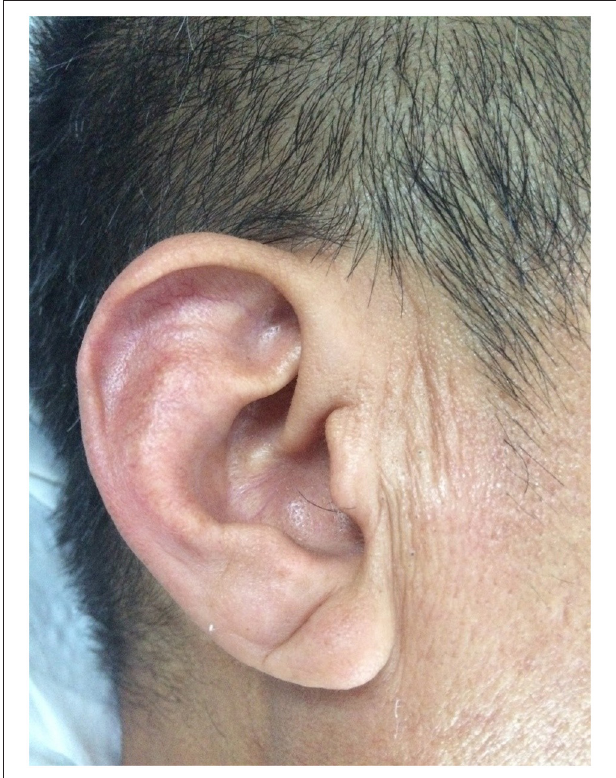
FIGURE 1 | Typical example of a bilateral earlobe crease.